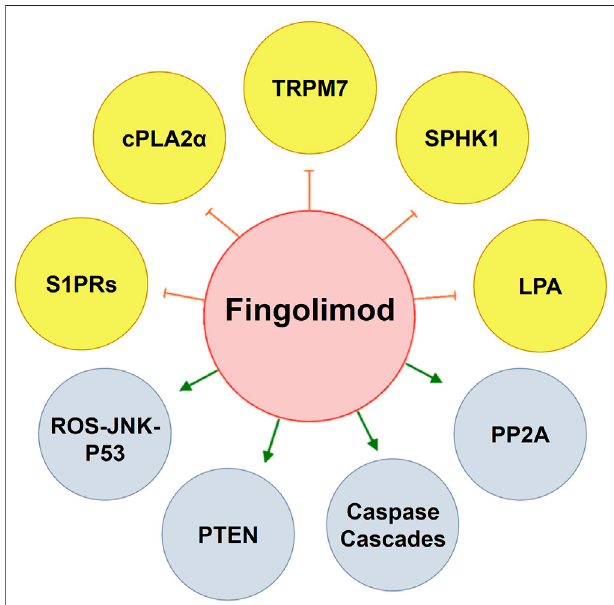
FIGURE3| Bymodulatingkeypathwaysinoncogenesis, fi ngolimodhas the potential use for cancer therapy. Fingolimod activates PP2A that plays a principal role as a regulator of cell cycle/division and growth. Fingolimod can induce apoptotic pathways by activation of caspase cascades, enhancing PTEN which inhibits pAkt, and inducing (ROS-JNK-p53) loop- dependent autophagy. By modulating S1PRs, fi ngolimod anti-angiogenesis activityisalsoahelpincancertreatment.Antiproliferativeeffectson fi ngolimod at some points occur by inhibiting TRPM7, cPLA2 α , SPHK1, and LPA which makes the drug an interesting object in cancer research. cPLA2 α , cytosolic phospholipase A2; LPA, lysophosphatidic acid; PP2A, protein phosphatase 2A; PTEN, phosphatase and tensin homolog; S1PR, sphingosine 1- phosphate receptor; SPHK, sphingosine kinase; TRPM7, transient receptor potential cation channel, subfamily M; ROS-JNK-P53, reactive oxygen species-c-Jun N-terminal kinase-protein